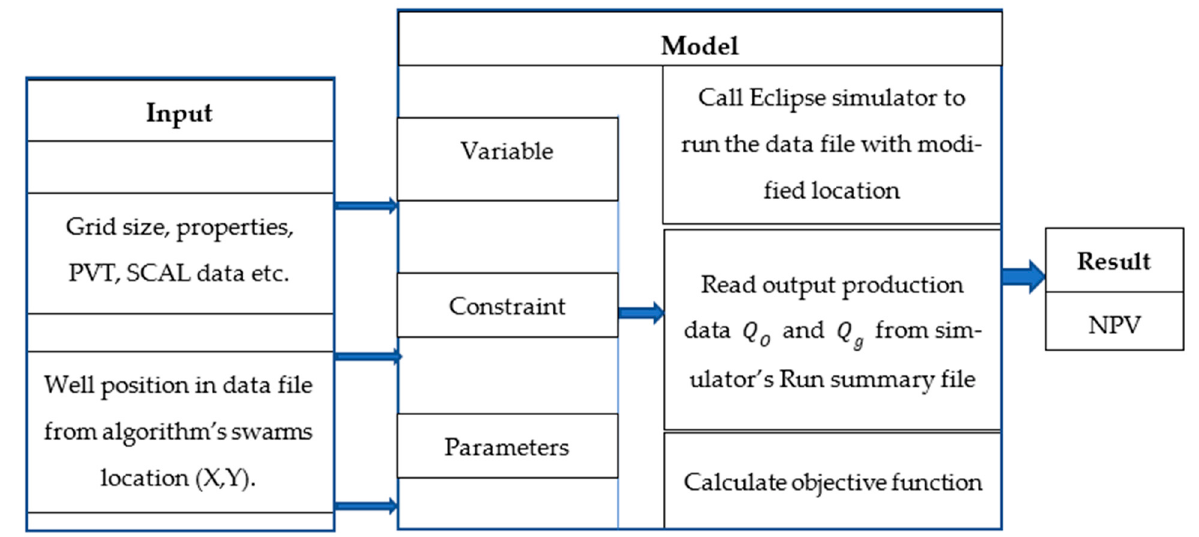
Figure 2. An overview of the optimization model.